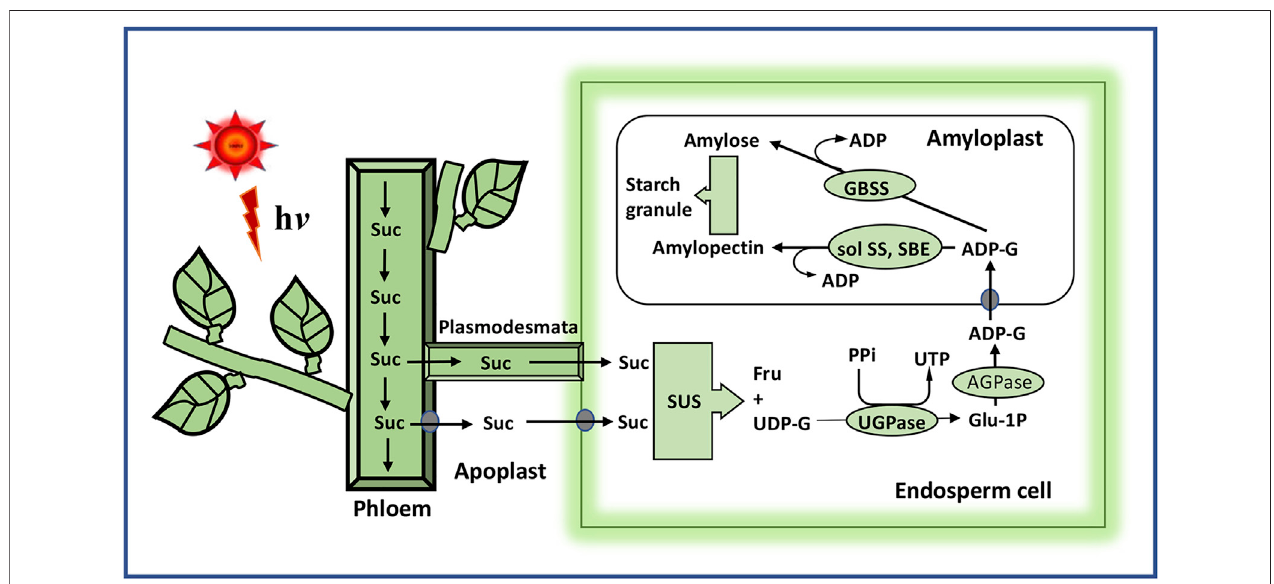
FIGURE 4 | Schematic presentation of starch synthesis from sucrose, the end product of photosynthesis, in the rice grain. Sucrose unloaded from the phloem enters the endosperm cells via the plasmodesmata or through the apoplast with the help of the sucrose transporter. The reactions leading to the synthesis of starch are described in the text. Suc, sucrose; SUS, sucrose synthase; UDP-G, uridine diphosphate glucose; UGPase, UDPG-pyrophosphorylase; AGPase, ADPG- pyrophosphorylase; sol SS, soluble starch synthase; GBSS, granule-bound starch